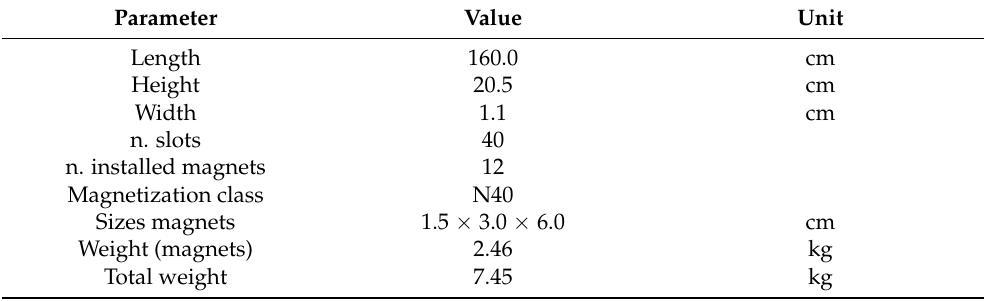
Table 3. Specifics of the